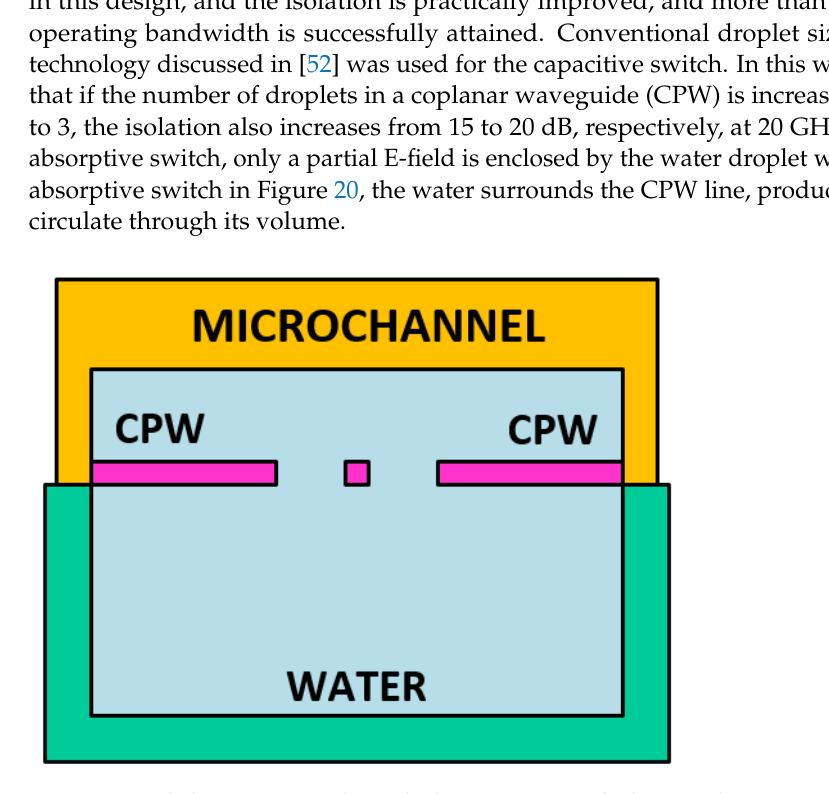
Figure 20. 2nd absorptive switch in which water surrounds the CPW